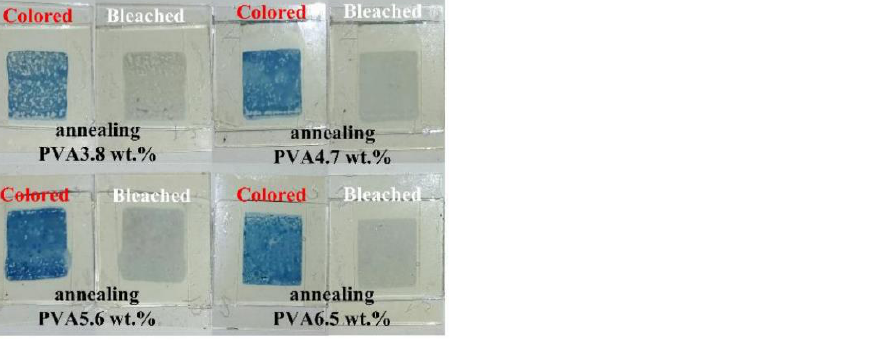
Figure 6. The photo images of screen-printed WO 3 electrochromic devices using different ink formulas [57].